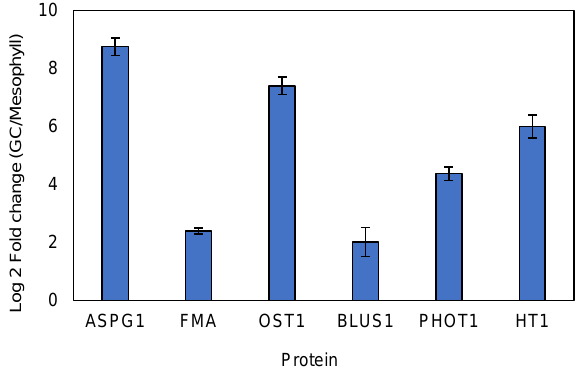
Figure 5. Fold change of selected guard cell-specific proteins in guard cell samples compared to mesophyll. Values are means of 5 replicates for GCs and 4 replicates for mesophyll ± SE. ASPG1: aspartic protease in guard cell 1; FMA: transcription factor; OST1: open stomata-1; BLUS1: blue light signaling 1; PHOT1: Phototropin-1; HT1: high leaf temperature 1.